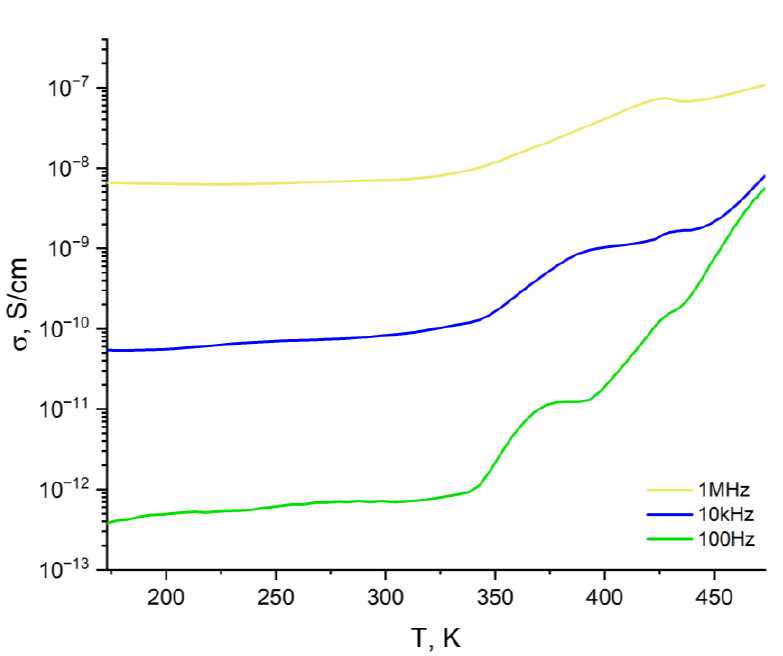
Figure 8. The frequency dependences of tanδ for polyNBi at various temperatures.